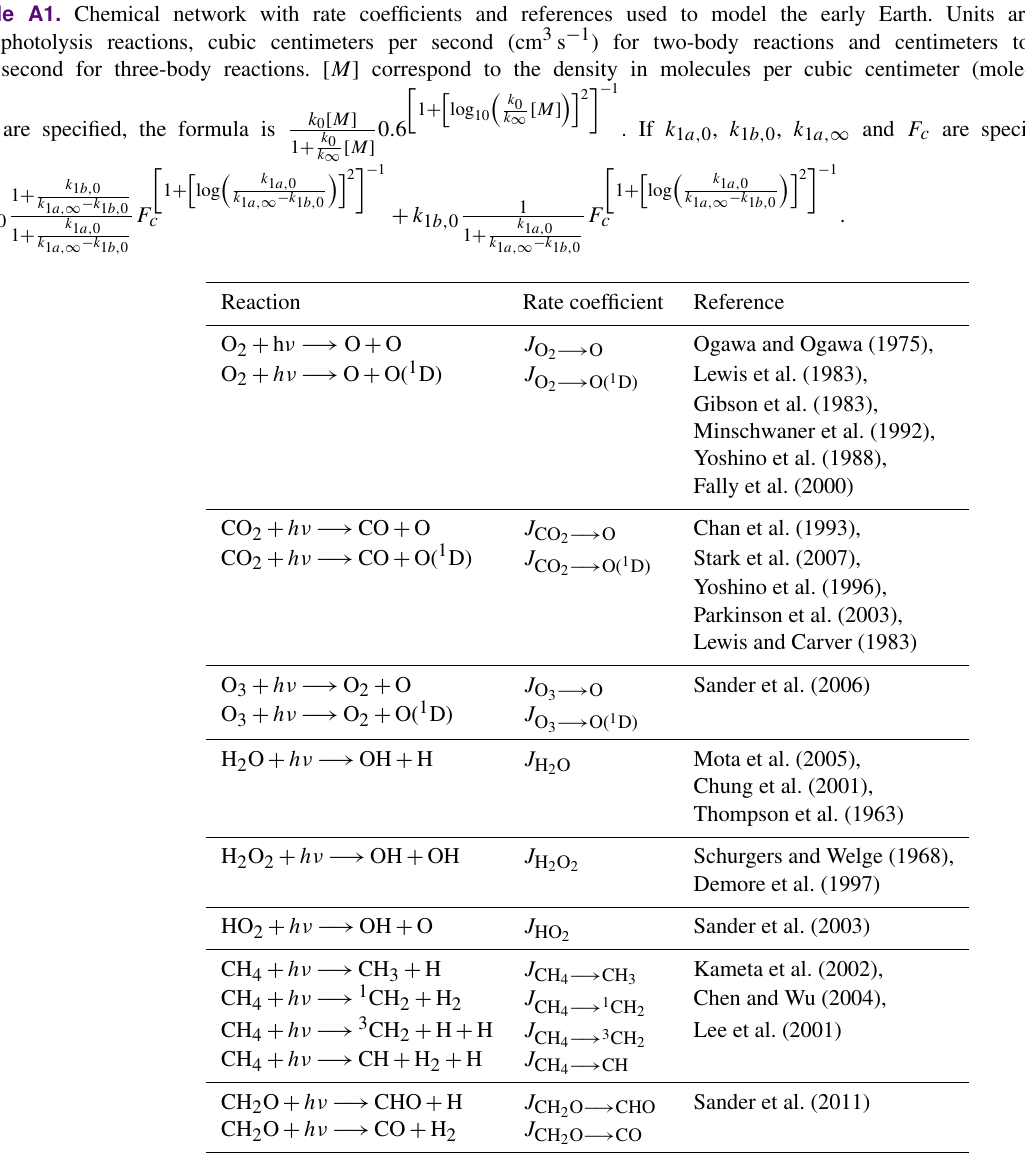
Table A1. Chemical network with rate coefficients and references used to model the early Earth. Units are per second (s − 1 ) for photolysis reactions, cubic centimeters per second (cm 3 s − 1 ) for two-body reactions and centimeters to the power of six per second for three-body reactions. [ M ] correspond to the density in molecules per cubic centimeter (molec.cm − 3 ). If k 0 and k ∞ are specified, the formula is k 0 [ M ] 0 . [ M ] 1 + k 0 k ∞